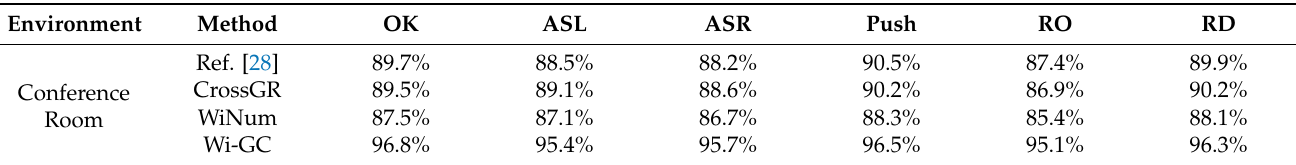
Table 1. Results of Wi-GC versus other